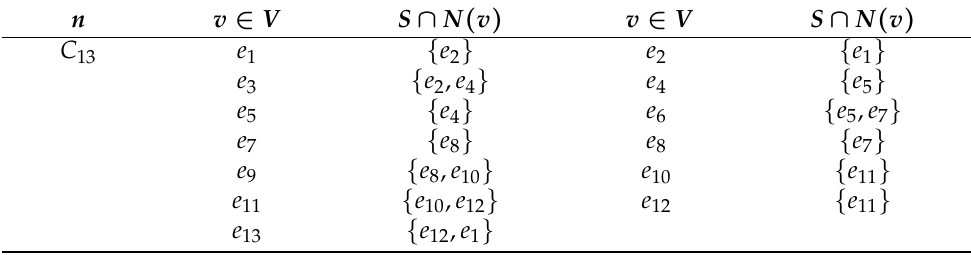
Table 2. Open locating-dominating vertices in C 13 .